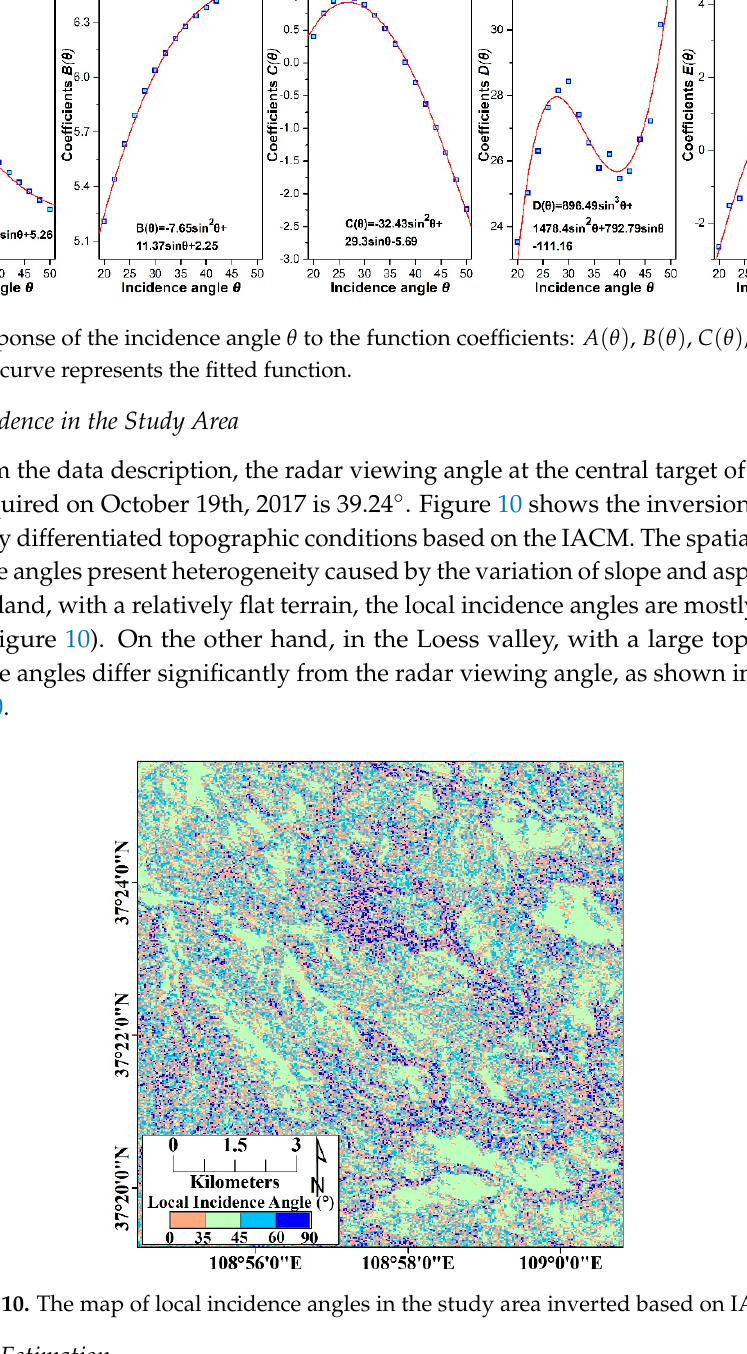
Figure 11. The map of volumetric soil moisture in the study area overlaying hillshade.